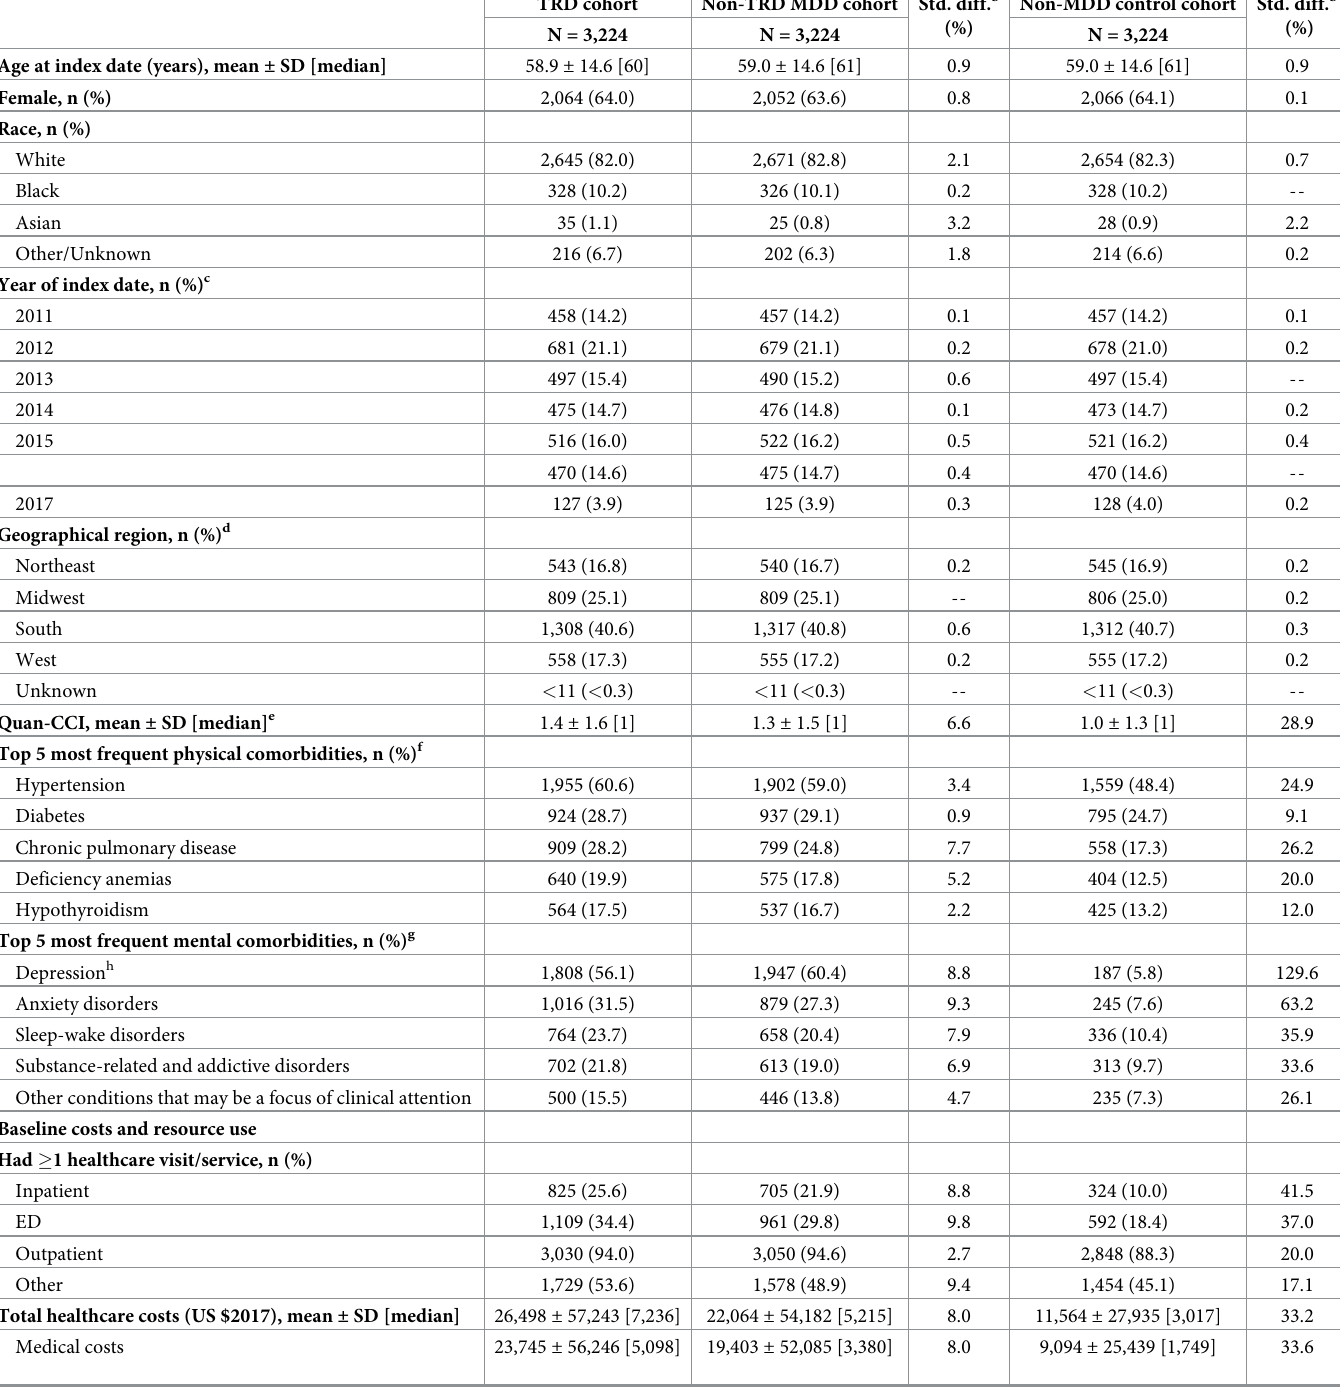
Table 1. Baseline characteristics of matched a cohorts (main